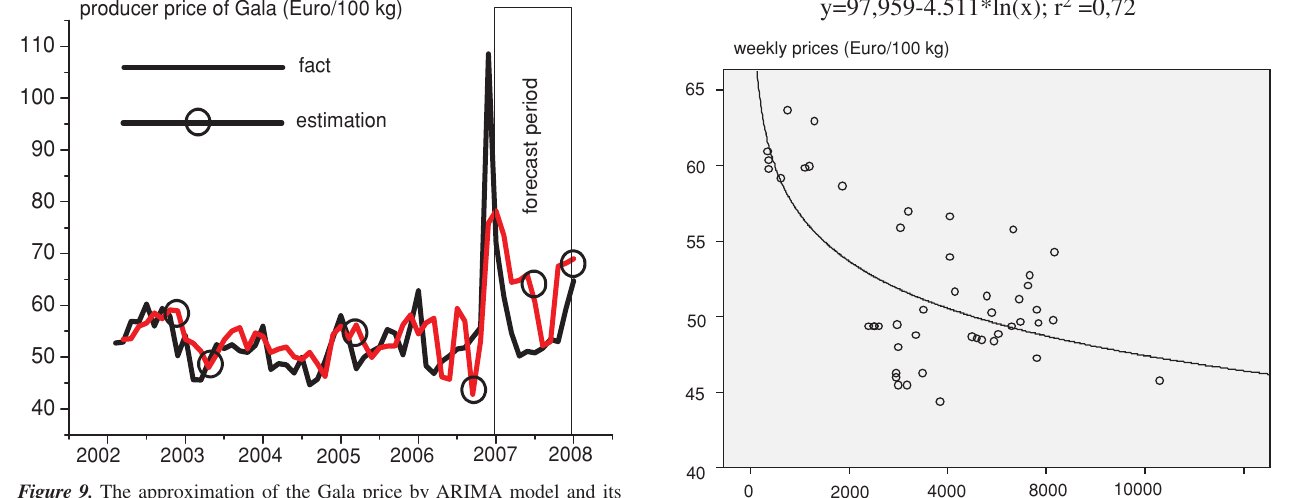
Figure 9. The approximation of the Gala price by ARIMA model and its